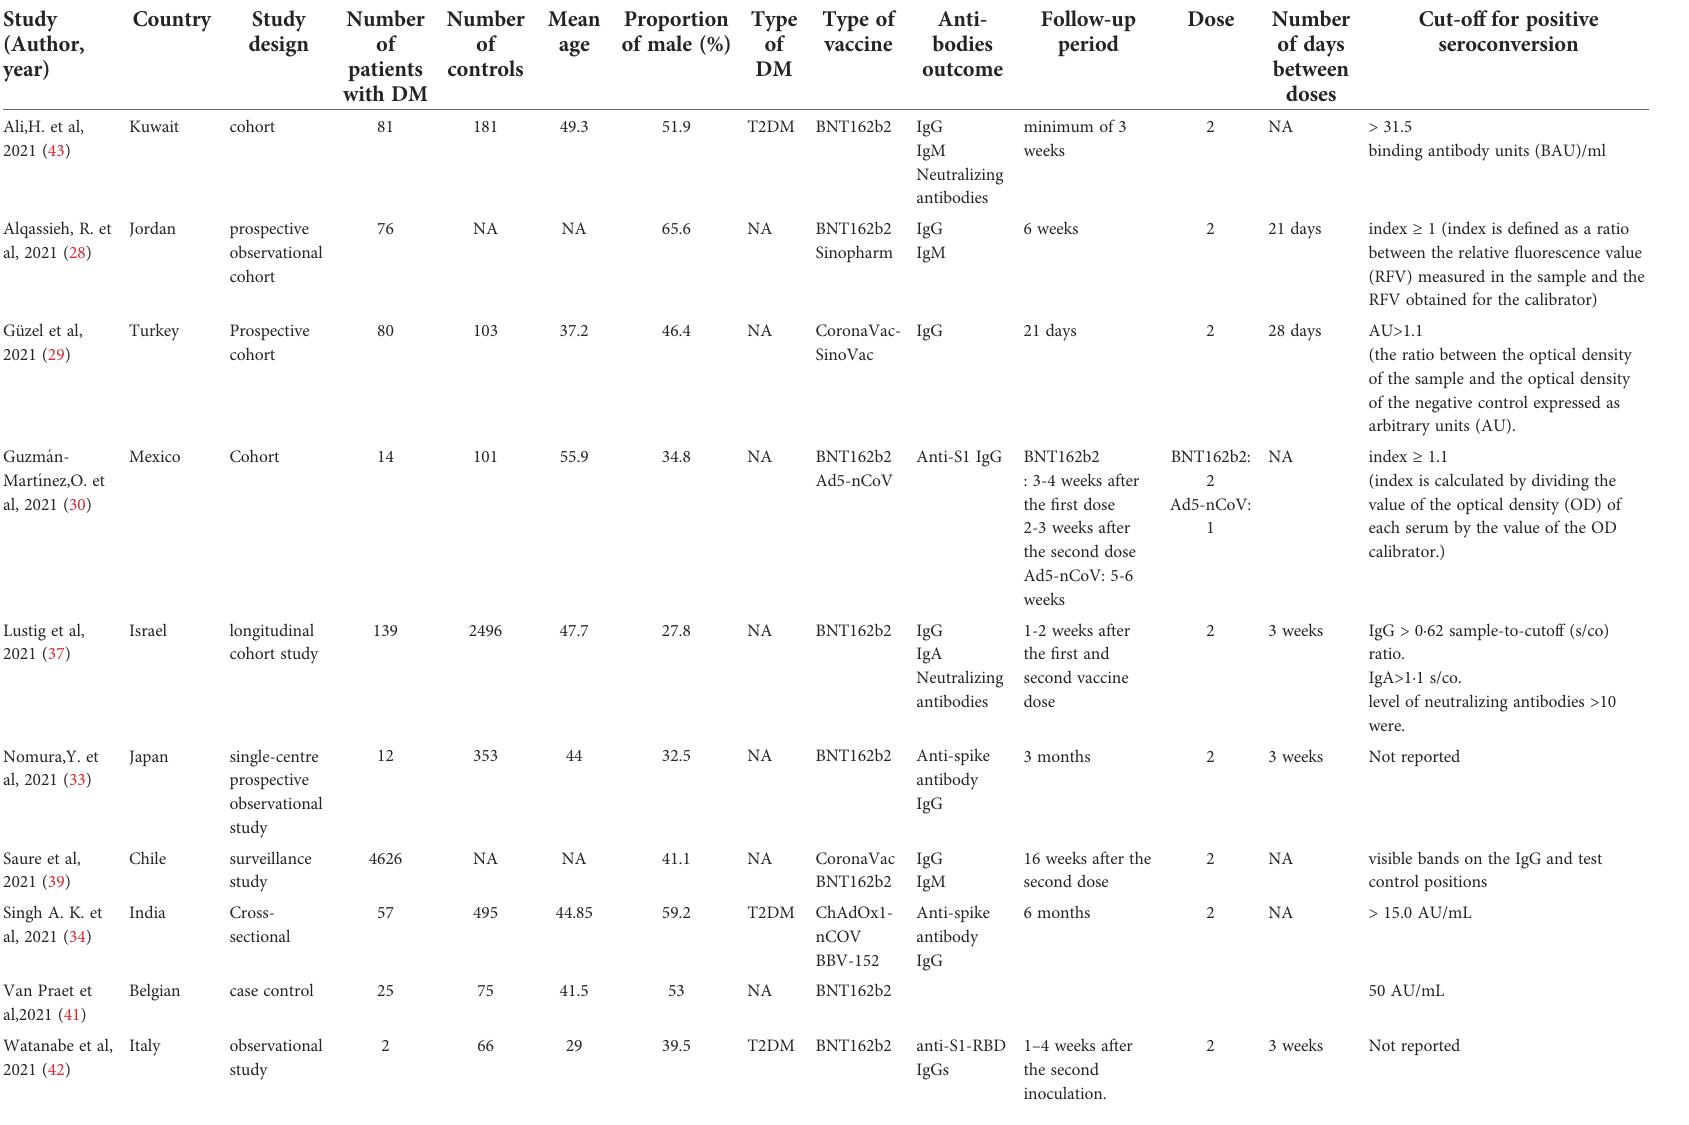
TABLE 1 Characteristics of the included